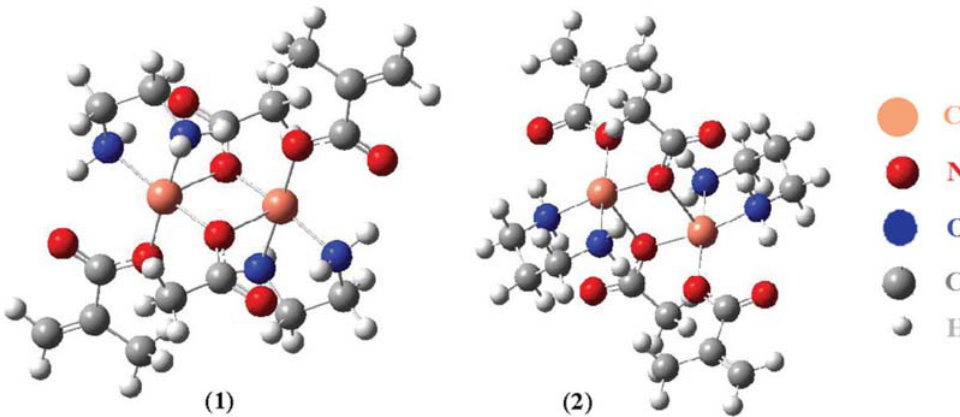
Fig. 4. The optimized structures of the complexes 1 and 2 .